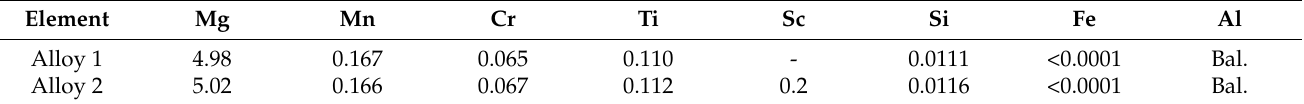
Table 1. Practical chemical compositions of the Al-5Mg alloys in this study (wt.%).